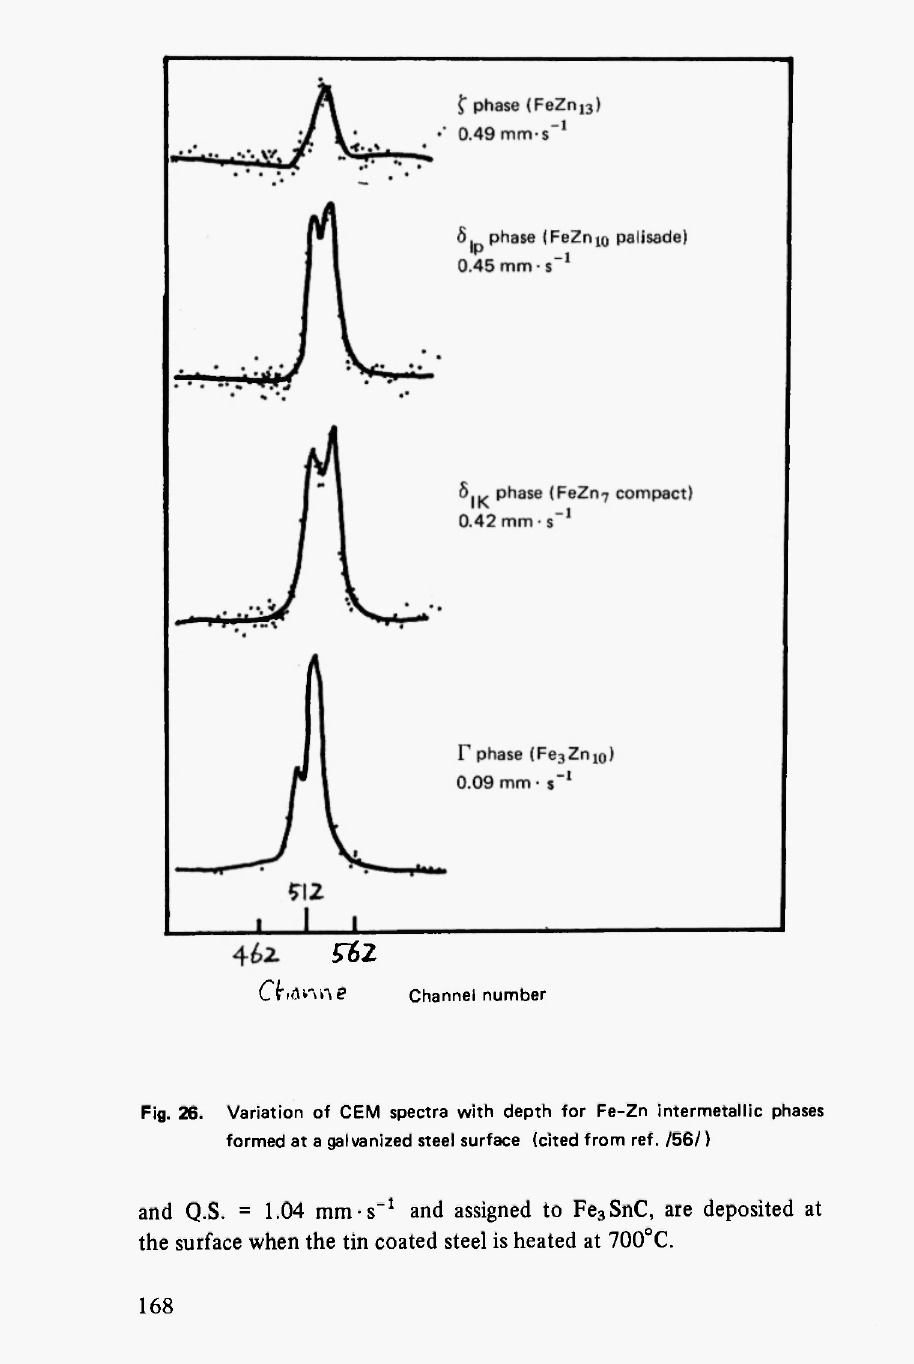
and Q.S. = 1.04 mm-s" 1 and assigned to Fe 3 SnC, are deposited at the surface when the tin coated steel is heated at